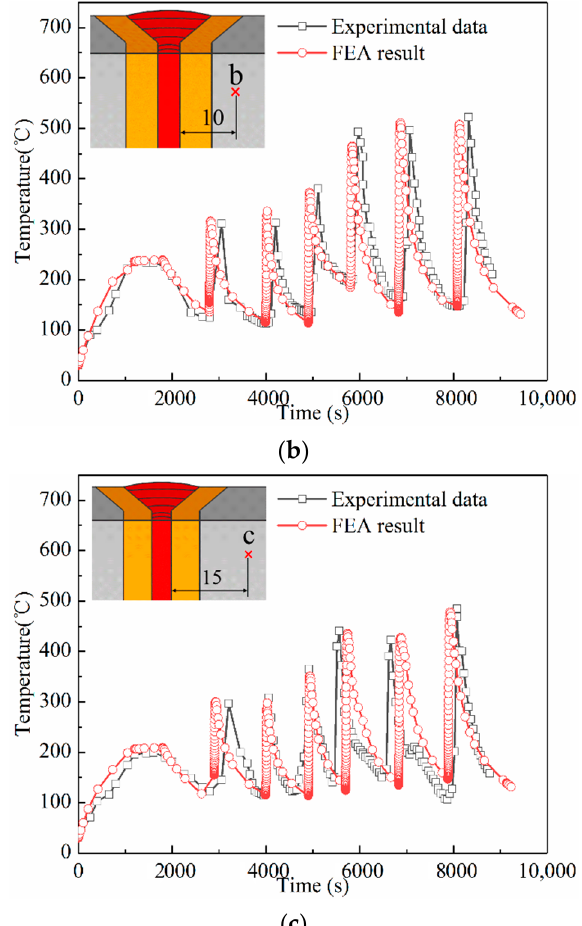
Figure 8. Comparison of the thermal cycle curves obtained from experiment and simulation at different points, a ( a ), b ( b ), and c ( c ). For the specific positions of a, b, and c points, refer to Figure 3. Both hoop stress S11 and axial stress S22 along outer surface P1 and inner surface P2 were measured by instrumented indentation method. There are seven points on each path. The detailed location is illustrated in Figure 9. Figure 10 shows the comparison between experimental results and simulation result of residual stress after different heat treatment. Overall, the simulation results are in good agreement with the measured value. It indicates that the simulation method could predict the residual stress precisely.